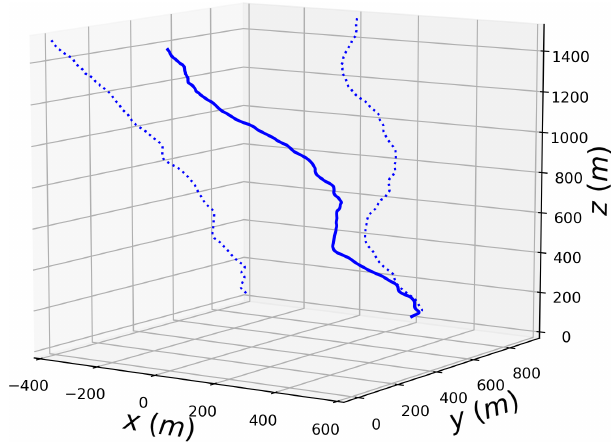
Figure 8. Trajectory (solid line) of a 0.5mm drop in a turbulent wind field for the low wind event. The dotted lines correspond to the trajectory projected on the (x,z) and (y,z)